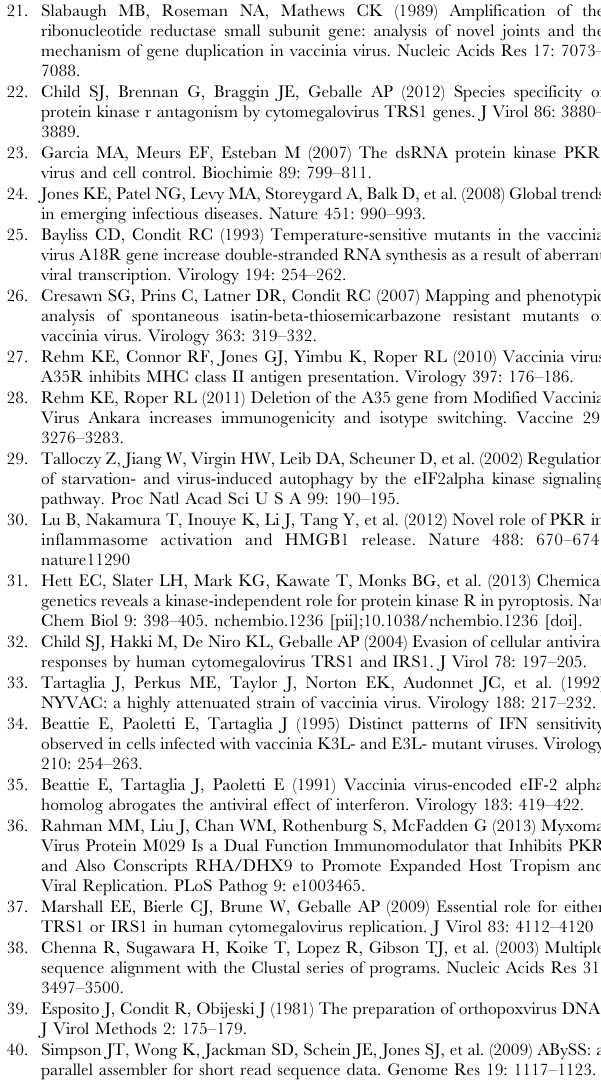
before nt 622 ( neoR - pcDNA3.1, Invitrogen). Table S1 Genomic coordinates for regions in whole genome alignment between Vaccinia copenhagen refer- ence (GenBank M35027.1) and parental genome (VV D E D K + RhTRS1 genome) sequenced here, as deter- mined by MUMmer 3.2.1 [ 44 ] . Table S2 Substitution and short indel variants ( , 10 bp) present in parental genome (VV D E D K + RhTRS1) as compared to Vaccinia Copenhagen genome (excluding any in the inverted terminal repeat regions). Predicted effects upon protein coding genes as annotated in the Copenhagen reference are listed, with more than one line per variant indicating effects upon multiple overlapping gene models.